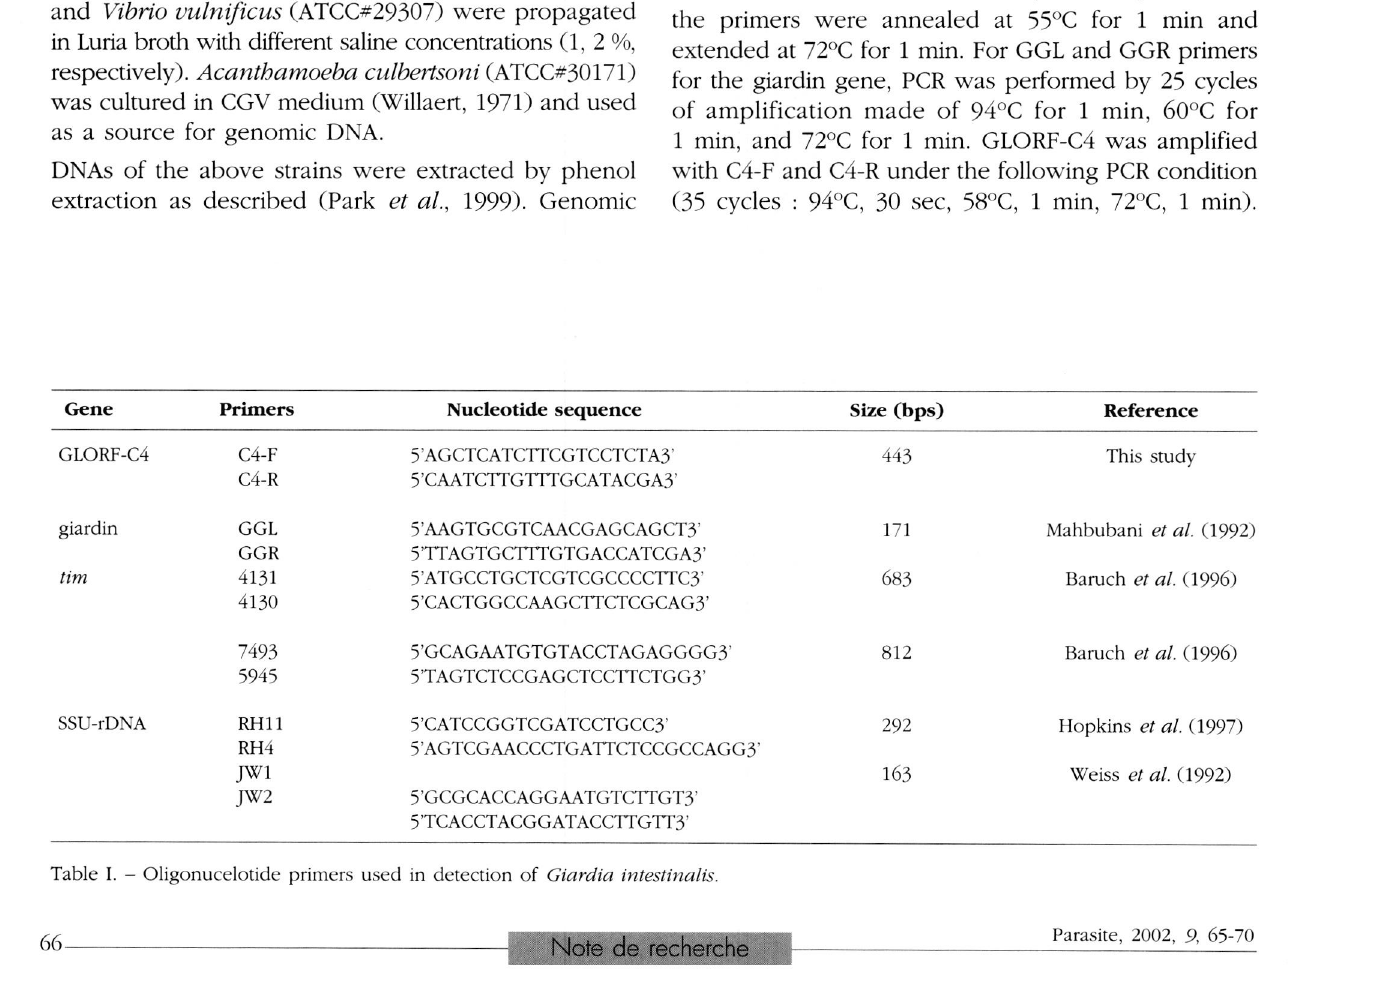
Table I. - Oligonucelotide primers used in detection of Giardia